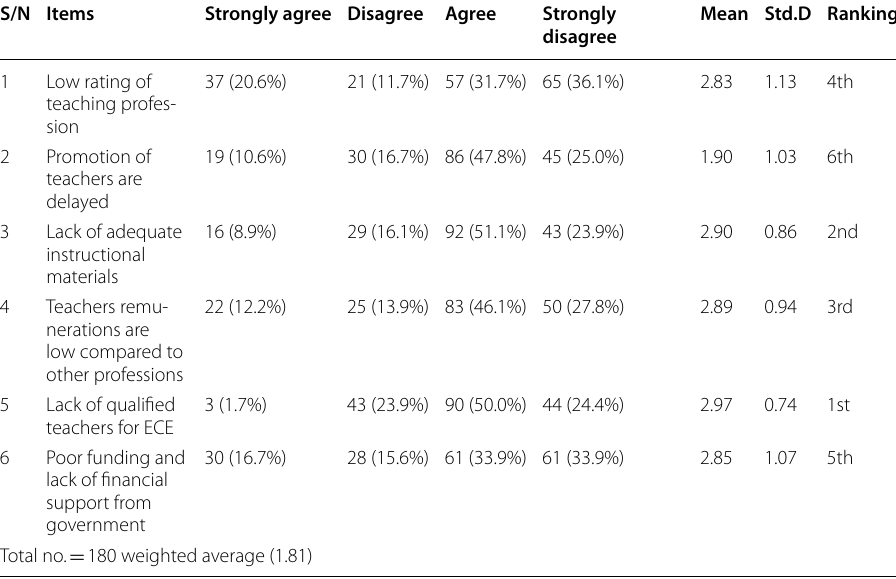
“Source: Research